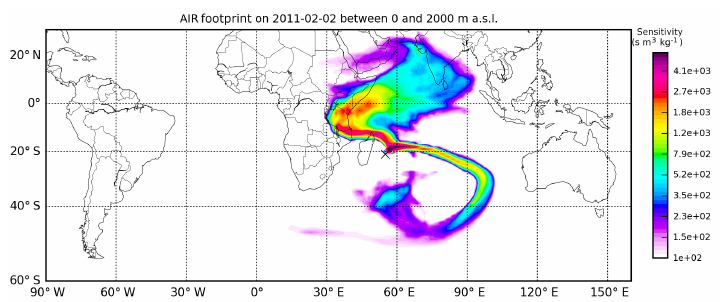
Figure A2. The emission response sensitivity of the air mass above Reunion Island in the vertical range from 0 to 2000ma.s.l. on 2 Febru- ary 2011 simulated with a 20 day backward run with FLEXPART